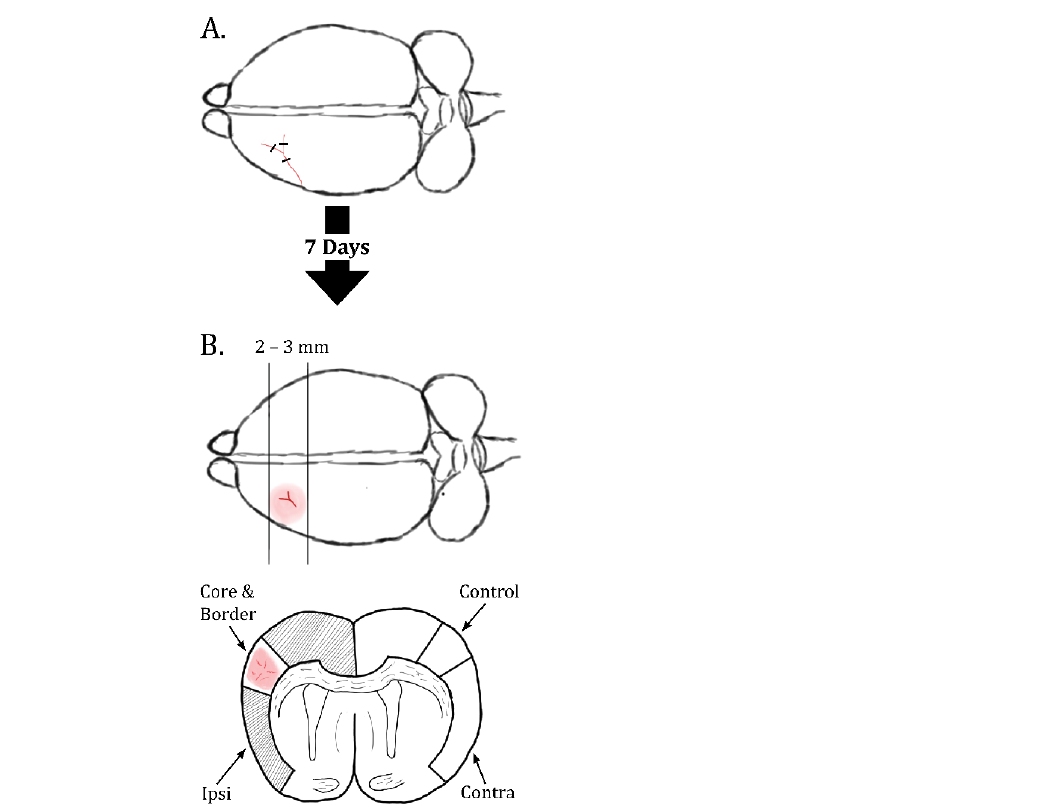
Figure 6. Illustration of dMCAO and dissection. ( A ) The distal parts of the middle cerebral artery are occluded on the surface of the cortex at the bifurcation of the artery. A triple electrocoagulation is used to ensure full occlusion. One week post dMCAO, mice were sacrificed and dissected as shown in ( B ). First a coronal slice was made, encompassing the visible stroke area on the brain surface. Ipsilateral cortex was divided into the visible stroke area (core and border) and rest of ipsilateral cortex (Ipsi), while from contralateral cortex, a control area corresponding to the anatomical location of the infarct area (Control) was separated from the rest of the contralateral cortex (Contra). For protein extraction, mice were anesthetized with isoflurane and decapitated. The brains were promptly extracted from the skull and dissected (Figure 6B) by coronal sec- tioning encompassing the visible stroke area. The cortex was divided into the following regions: the Ipsilateral Infarct area (Infarct), the rest of the ipsilateral cortex (Ipsi), the con- tralateral control (Control) corresponding anatomically to the infarct area, and the rest of the contralateral cortex (Contra). Samples were collected on dry ice and stored at − 80 °C until protein extraction.